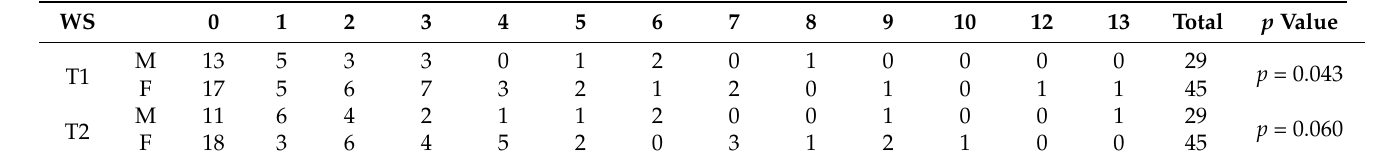
Table 3. The distribution of WS at T1 and T2 for males and females, respectively. WS